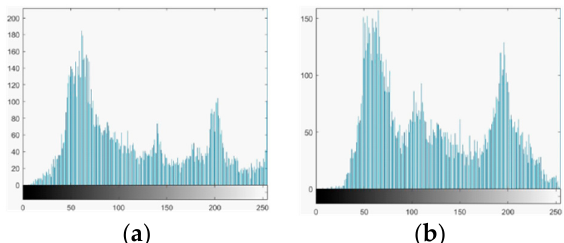
Figure 14. Gray-level histograms. ( a ) Taillight histogram in the lit state; ( b ) Taillight histogram in unlit state.